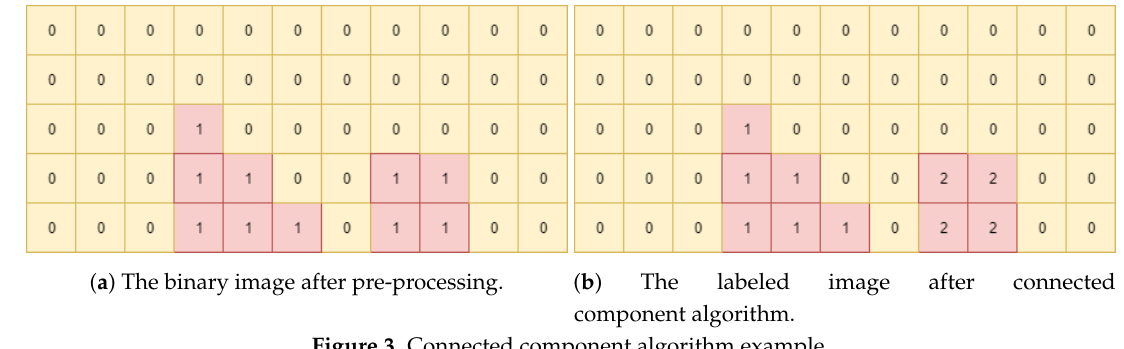
Figure 3. Connected component algorithm